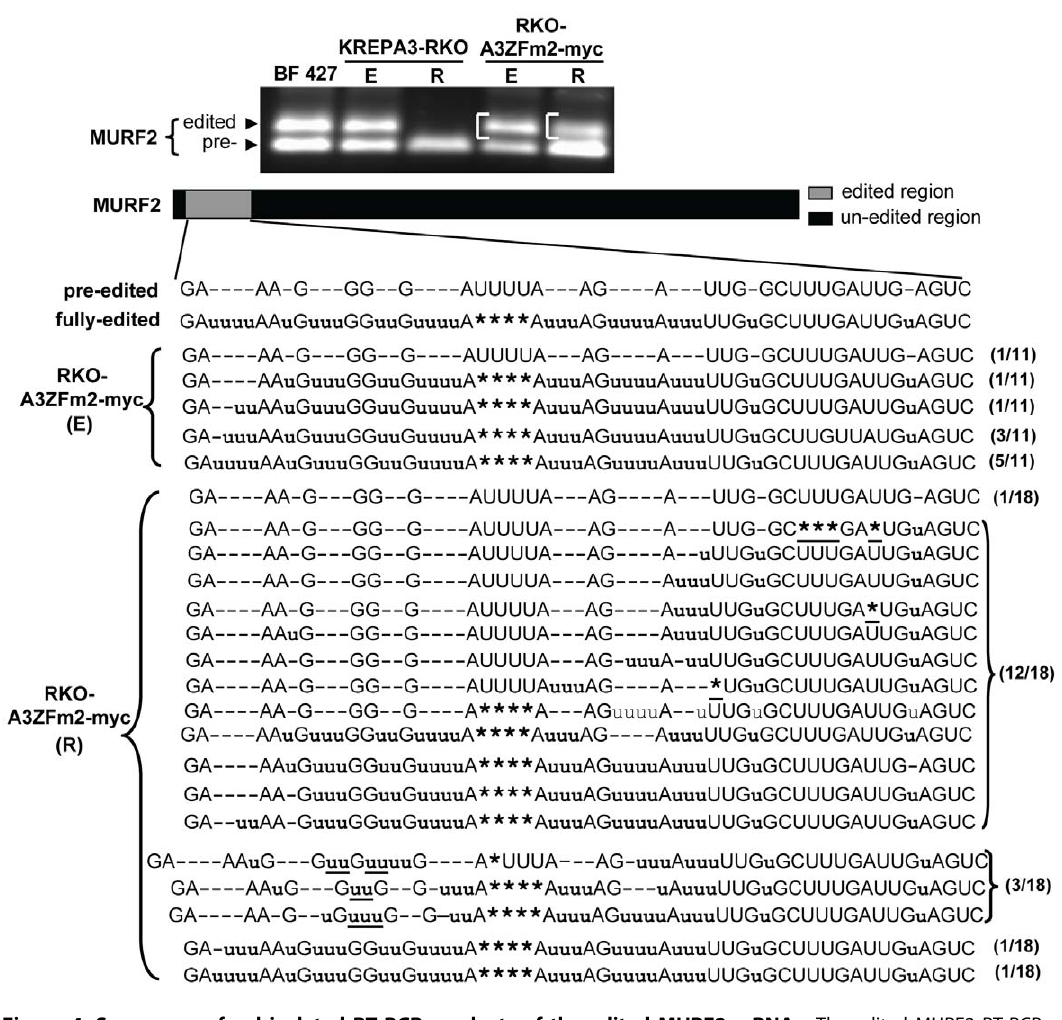
Figure 4. Sequences of gel isolated RT-PCR products of the edited MURF2 mRNAs. The edited MURF2 RT-PCR products (indicated by brackets) from RKO-KREPA3ZFm2-myc cells with KREPA3 Reg expressed (E) and repressed (R) were cut from agarose gel, cloned and sequenced. The inserted, deleted, and non-matching positions and numbers of sequenced clones are indicated as in Figure 3.